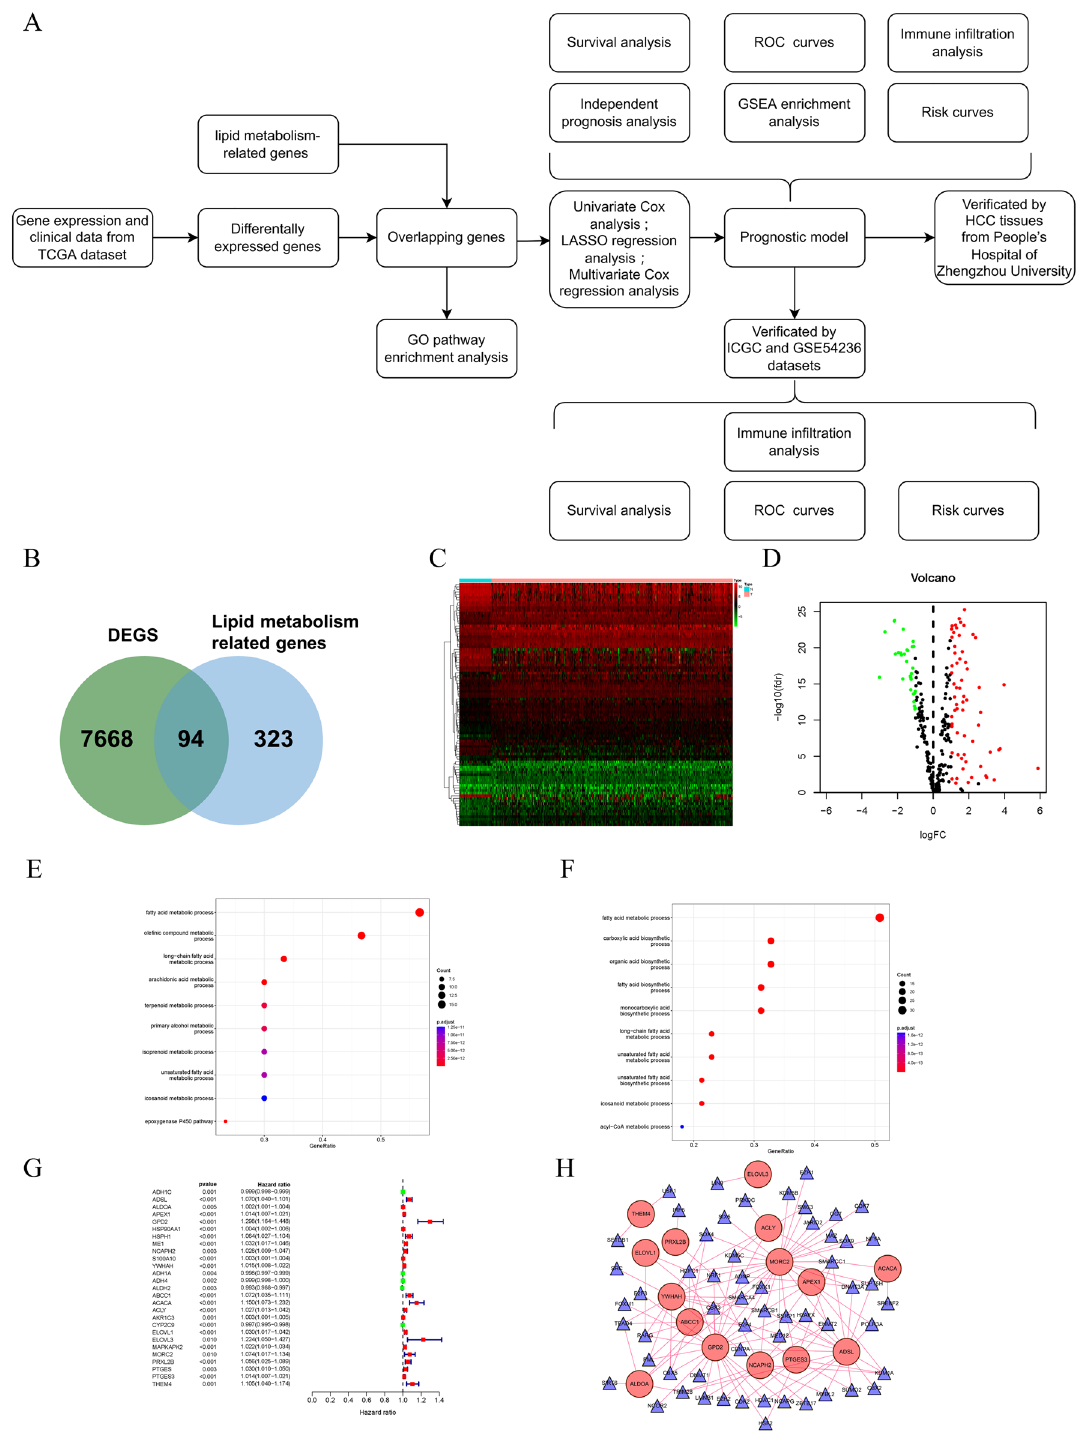
Figure 1. Differentially expressed and lipid metabolism related and prognosis-related genes. ( A ) Flowchart of the study. ( B ) Venn diagram of 7668 differential expressed genes and 323 genes related to lipid metabolism. ( C ) Heat map of overlapping genes (using “pheatmap” R package, https:// cran.r- proje ct. org/ bin/ windo ws/ base/ old/4. 1.3/). ( D ) Volcano map of overlapping genes. ( E , F ) GO pathway enrichment analysis of TCGA cohorts. ( G ) Hazard ratios of prognosis-related genes. ( H ) Transcription factor regulatory network. Red, positive regulation; green, negtitive